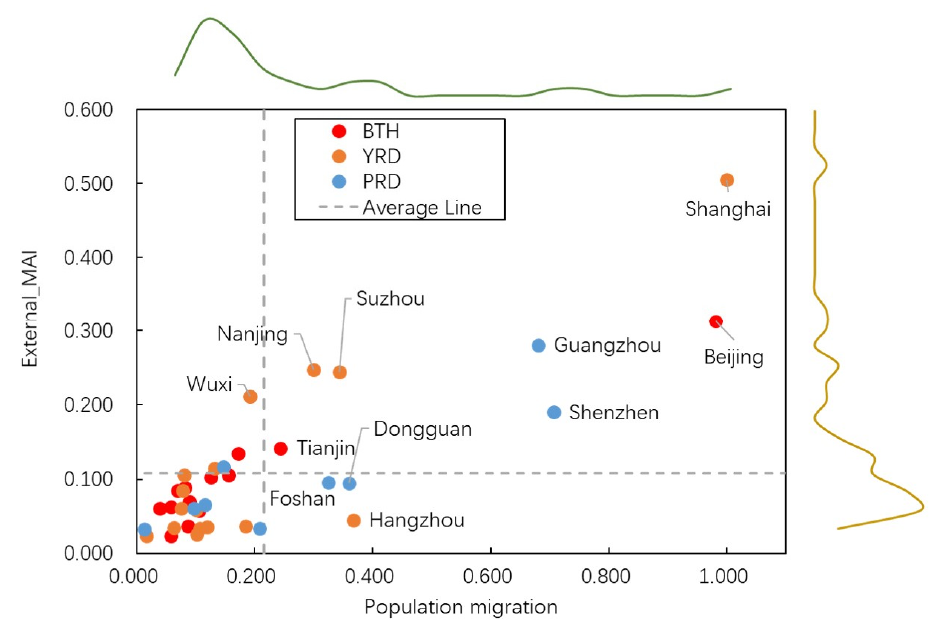
Figure 3. Scatter plot of external-MAI and migration population.